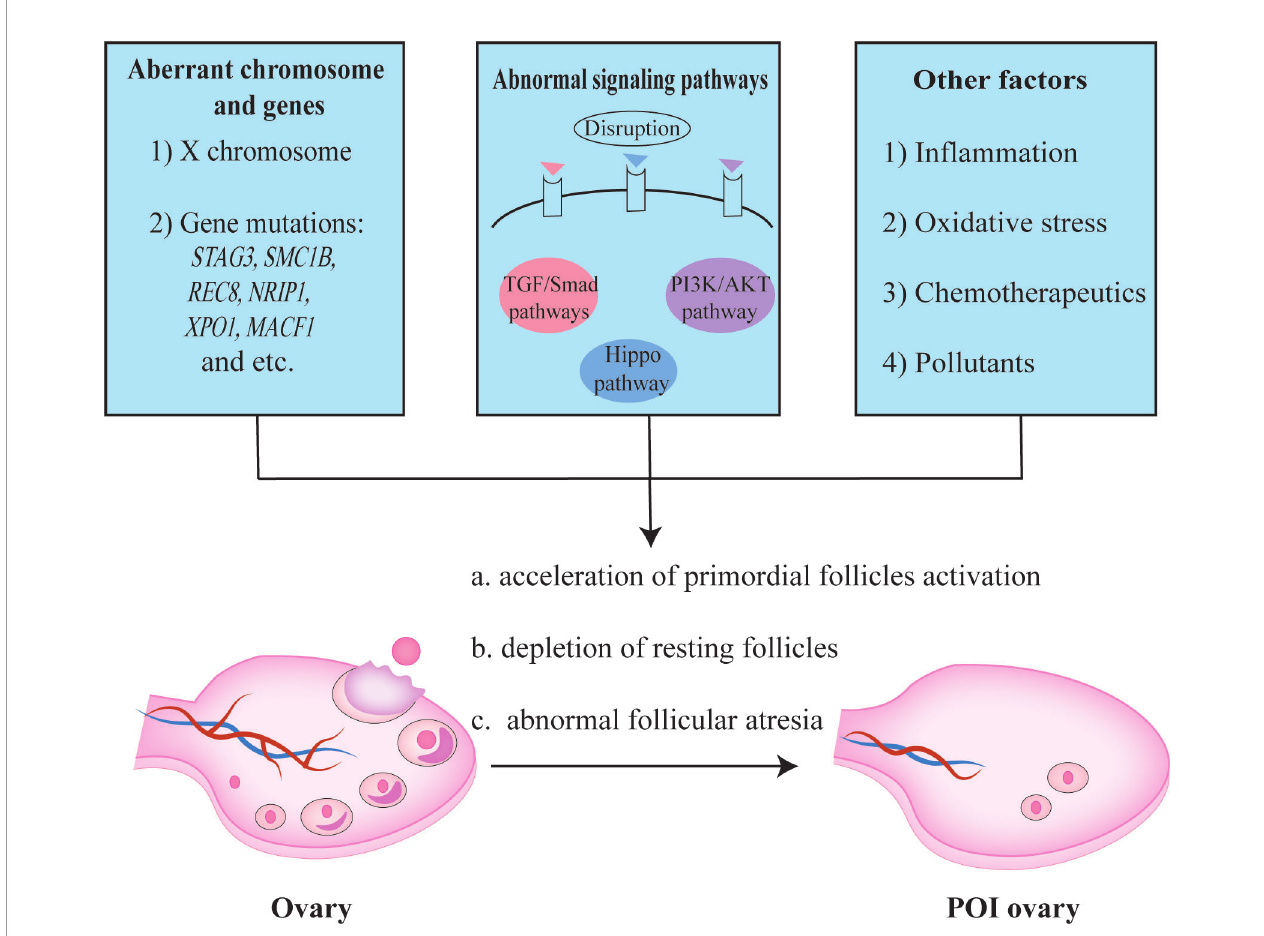
FIGURE 3 | The pathogenesis of POI. Aberrant X chromosome and genes, abnormal signaling pathways, in fl ammation response, oxidative stress, etc. contributed to the occurrence of